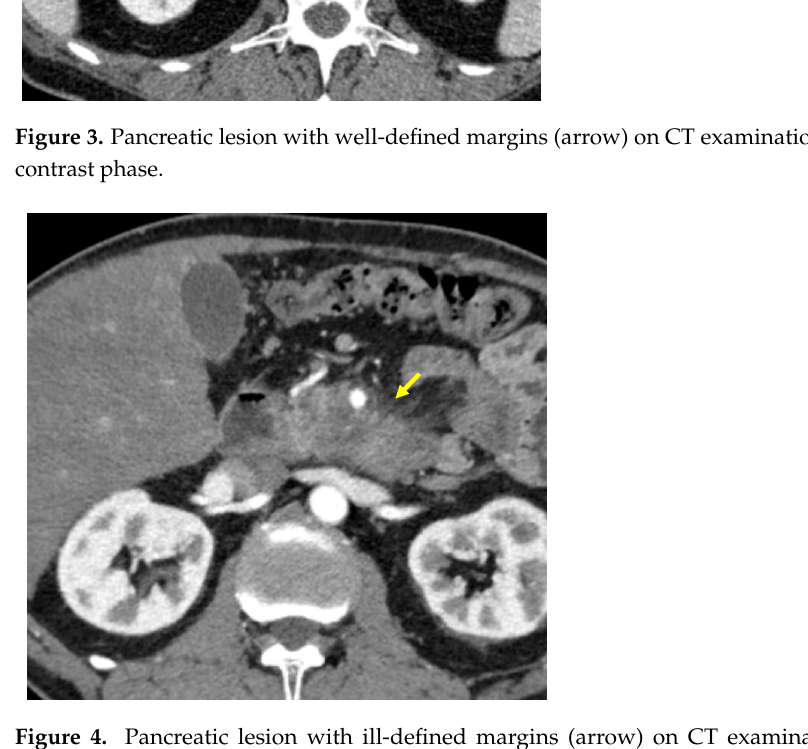
Figure 5. Pancreatic lesion with ill-defined margins (arrow) on CT examination in portal-venous contrast phase. Arterial invasion was detected in 74 (86.04%) metastatic patients and in 79 (39.11%) non-metastatic patients. Venous invasion was observed in 83 (96.51%) metastatic patients and in 98 (48.51%) non-metastatic patients. Visual lesion assessment in the portal-venous phase showed a significant statistical difference in the two groups, appearing hypodense, respectively, in 80 (93.02%) metastatic patients and 108 (53.46%) non-metastatic patients. Quantitative features are presented in Table 2.